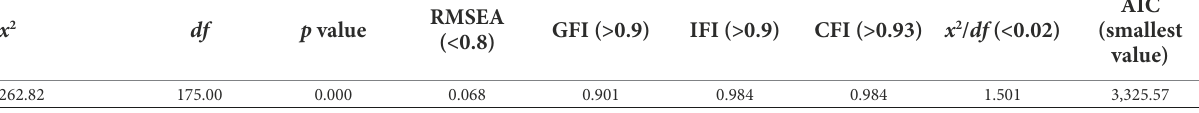
TABLE 3 Goodness of fit index of the relation between employees’ emotional awareness, affective commitment to the leader, and organizational commitment.